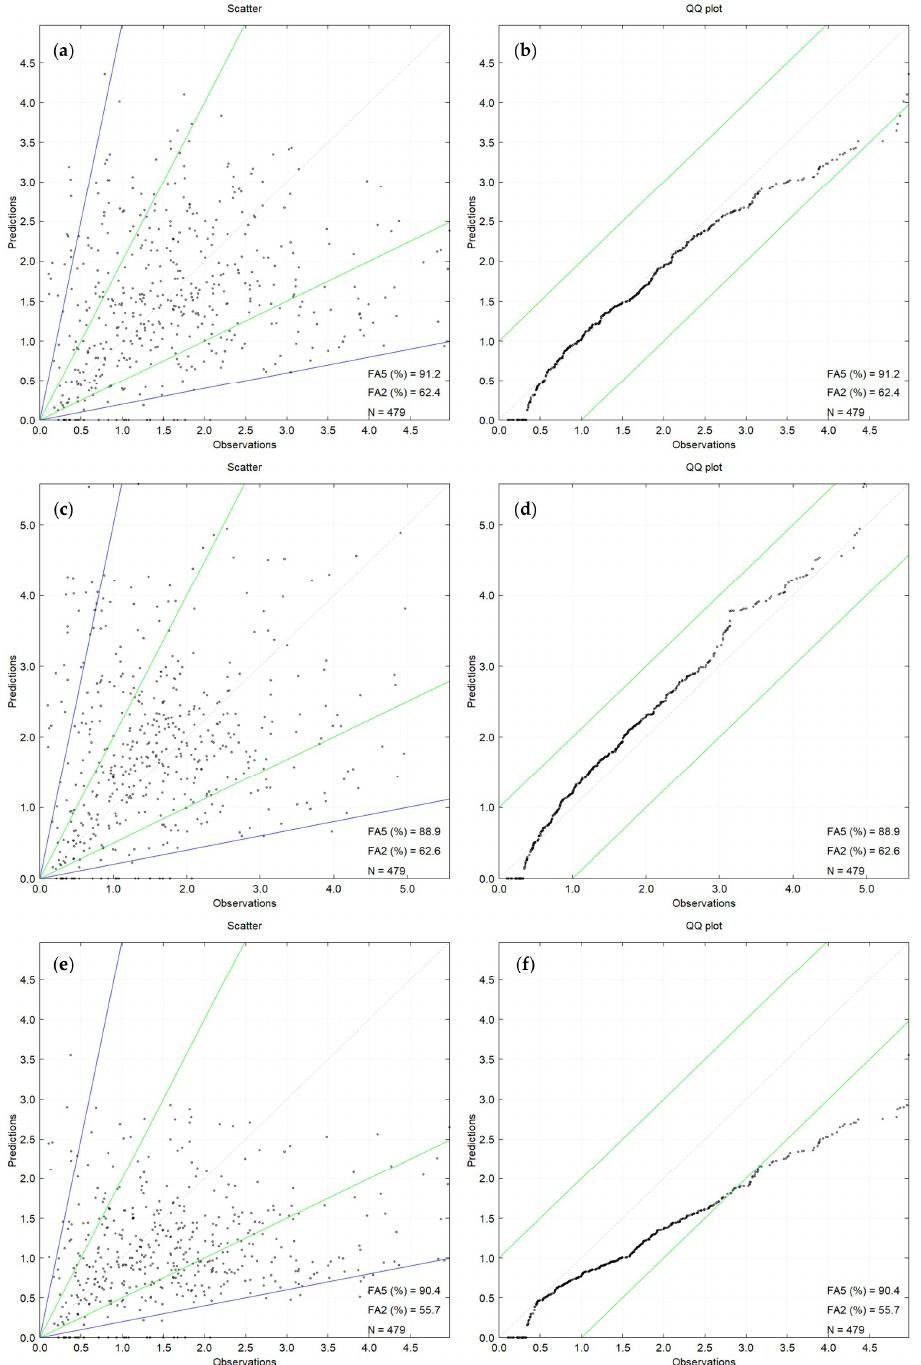
Figure 1. Scatter plots and QQ plots for Indianapolis best-quality data ( µ g m − 3 ): ( a ) WT plume rise scatter plot; ( b ) WT plume rise QQ plot; ( c ) JJ + RS plume rise scatter plot; ( d ) JJ + RS plume rise QQ plot; ( e ) JJ + JJ plume rise scatter plot; ( f ) JJ + JJ plume rise QQ plot. It is observed that the regions of FA2 and FA5, delimited by the green and the blue lines of the scatter plots, respectively, are quite similar for the three plume rise algorithms: FA2 ranges from